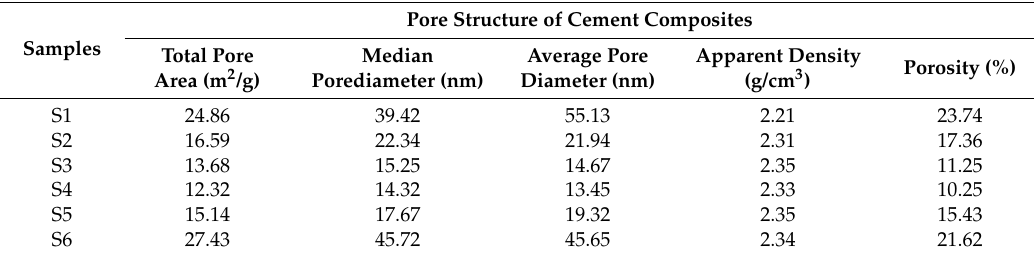
Figure 8. The variation of drying shrinkage value of GO/cement composites with hydration time. Table 7. Pore structure of GO/cement composites at 28